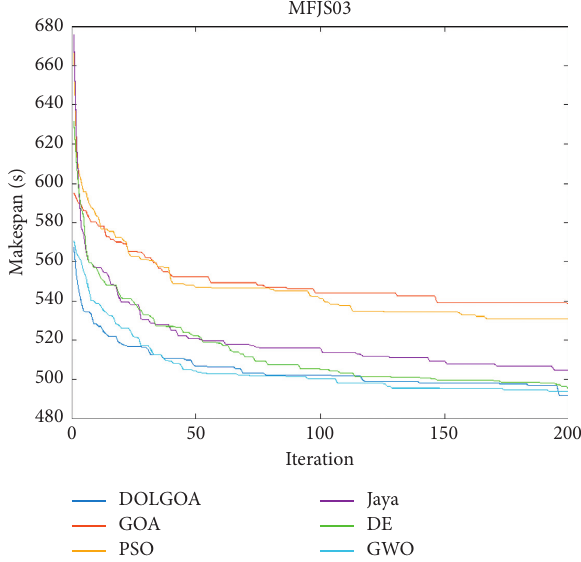
Figure 5: Convergence results of MFJS03 for all the compared